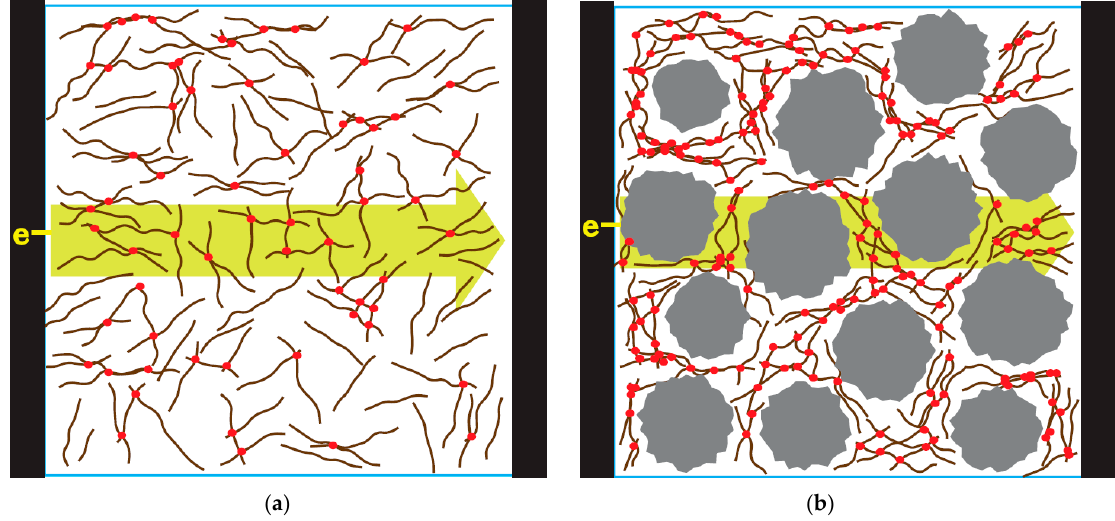
Figure 1. Scheme of ( a ) nanotube composite and ( b ) segregated nanotube composite with secondary micro-silica filler.